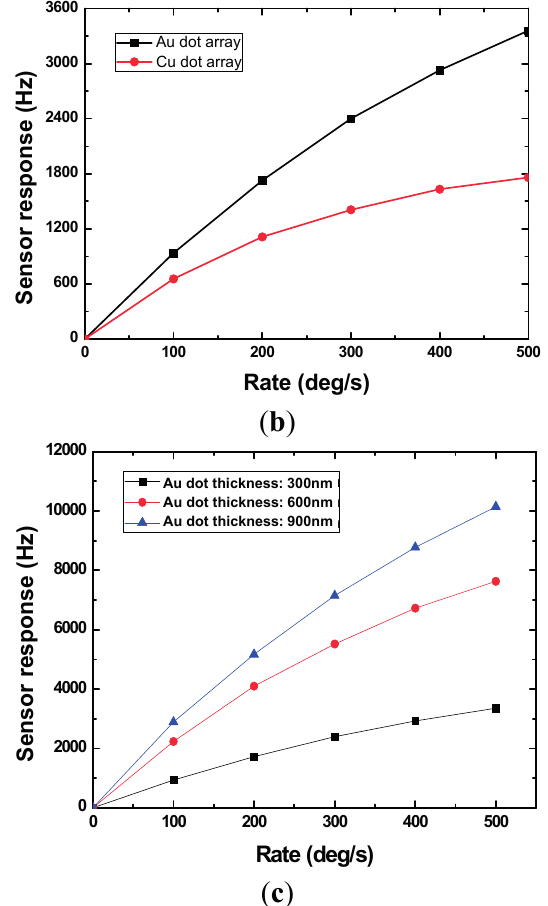
Figure 8. Gyroscopic effect comparison among various piezoelectric substrate ( a ), metallic dot material ( b ), and dot thickness ( c ), sensor operation frequency: 95 MHz.